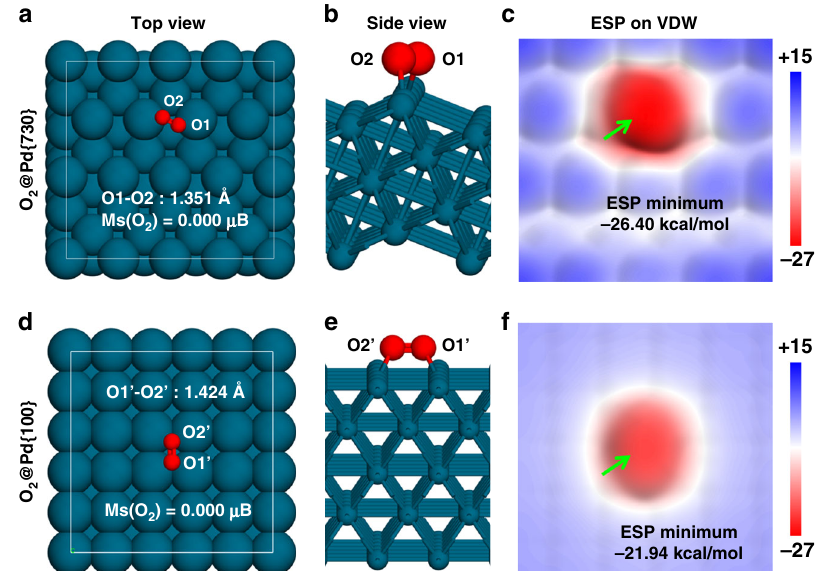
Fig. 3 The dissociative adsorption of O 2 on the Pd {730} and Pd {100} facets. a , b , d , e Top and side views of DFT optimized structures of O 2 molecule adsorbing on Pd{730} and Pd{100} surfaces. c , f The electrostatic potential distributed on the electron density Van der Waals surfaces (isodensity = 0.001 a.u.) of O 2 @ Pd{730} and O 2 @ Pd{100}. The green arrows in c and f point to the global EPS minima of the two electron density